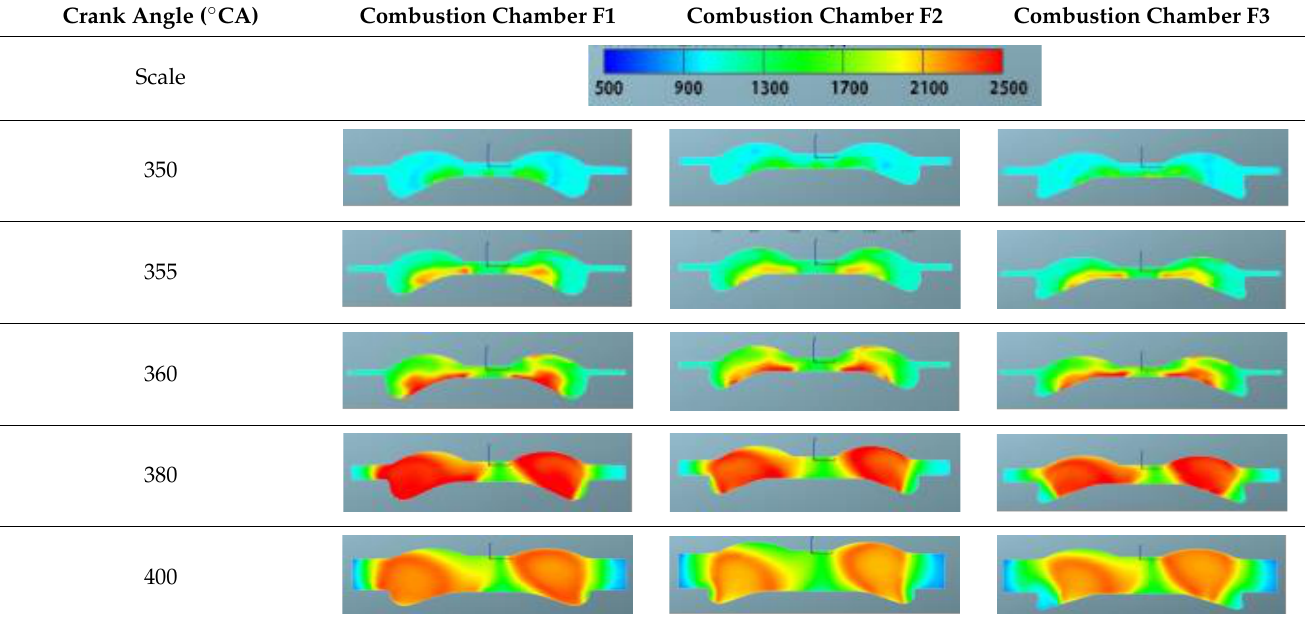
Table 17. Comparison of cylinder temperature nephograms of the three combustion chamber schemes matched with 160 ◦ spray angle